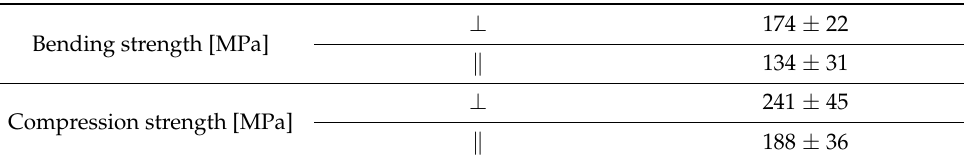
Figure 4. Images of C/C-SiC composite microstructure: ( a ) nonwoven cloth layer, ( b ) short-strip cloth layer, ( c ) cross-sectional view with needle fiber, ( d ) the different components of the final composite material (reprinted/adapted with permission from ref. [21]. 2022, Elsevier). Table 3. Mechanical properties of C/C-SiC composites (reprinted/adapted with permission from ref. [21]. 2022,